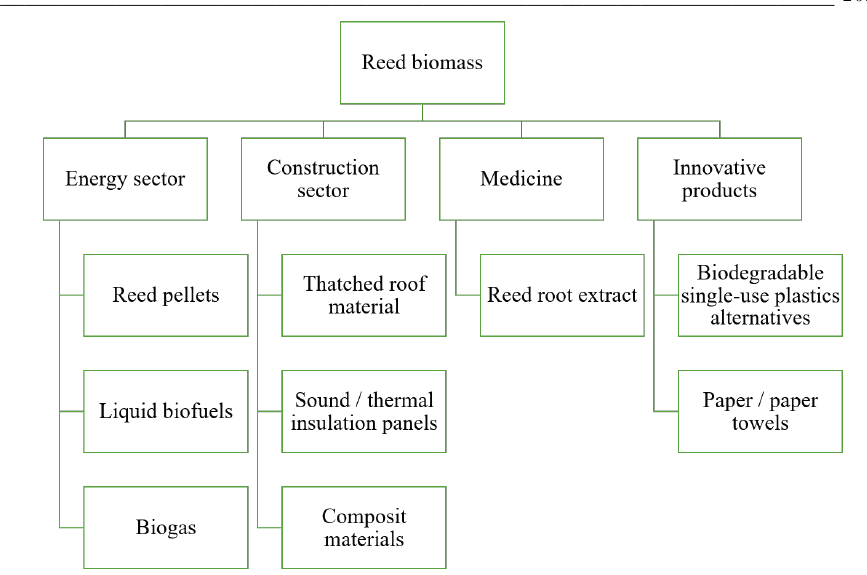
Fig. 2. Reed biomass use alternatives evaluated in this